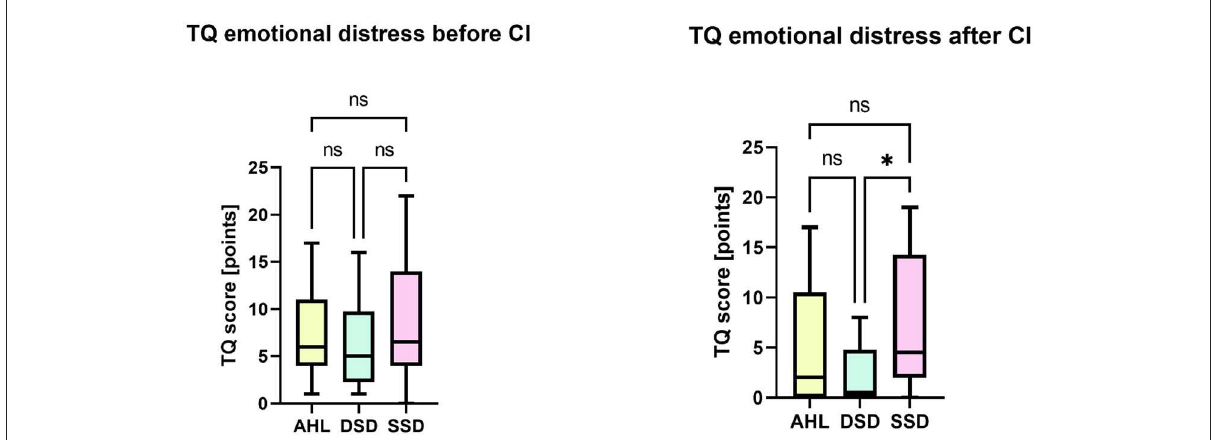
FIGURE2 Between-group differences regarding the TQ subscale “emotional impact of tinnitus”. Kruskal-Wallis with Bonferroni correction ( * p < 0.05) demonstrated that six months after cochlear implantation, the DSD group patients reported significantly less tinnitus-induced emotional distress than the SSD group. ns, not